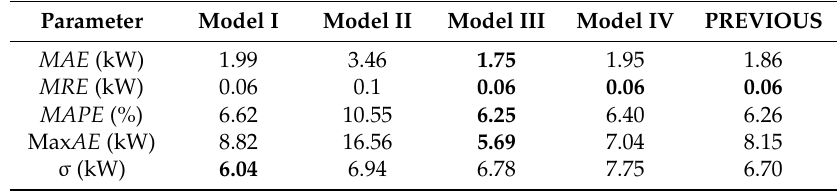
Table 14. Results obtained by MOGA and PREVIOUS models over Test C, for a PH of 1 h.